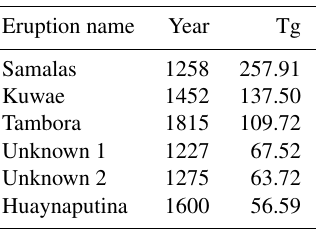
Table 1. Volcanic forcing used for ensembles. Volcanic forcing Ensembles